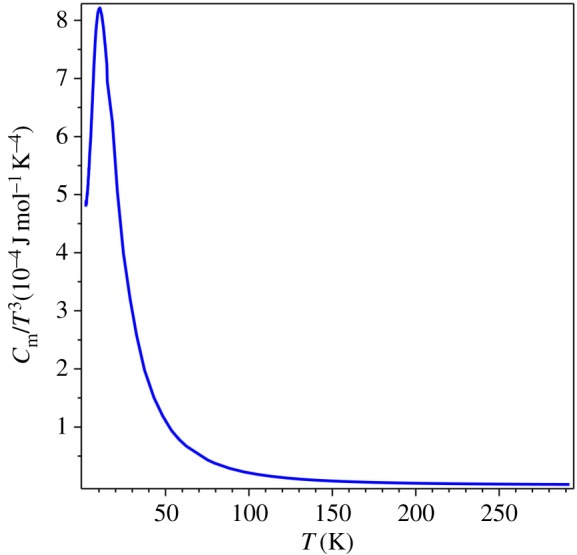
Cm/T3 vs T for AgCl [35,36].